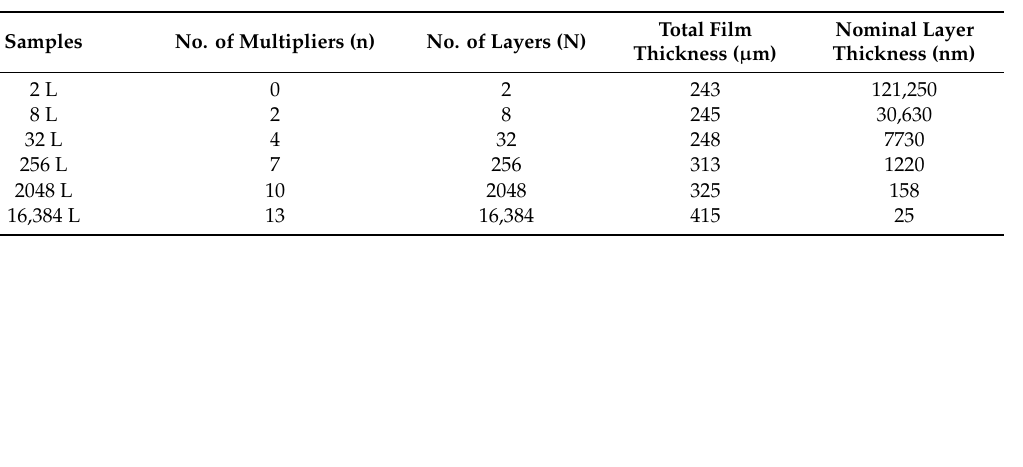
Figure 1. Schematic of the layer multiplying process in the multilayer coextrusion system. Table 1. Characteristics of coextruded PVDF-HFP / PC